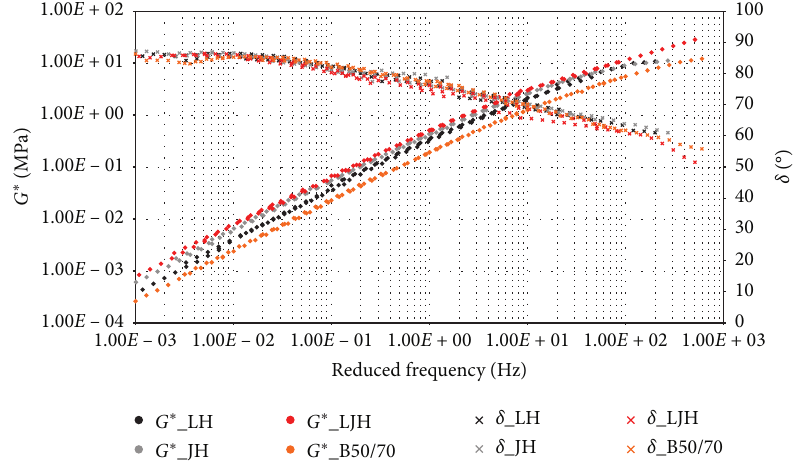
Figure 7: Master curve for hot mastics and neat bitumen 50/70.